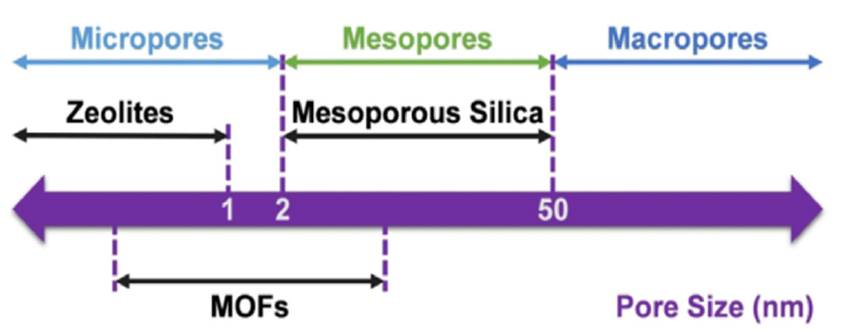
Figure 8. The pore size scheme for zeolites, mesoporous silica, and MOF. (Reproduced with permis- sion from [74]. Copyrights reserved Elsevier, 2020). Table 13. The concentration of pollutants before and after adsorption of silica, zeolite and activated carbon [75].